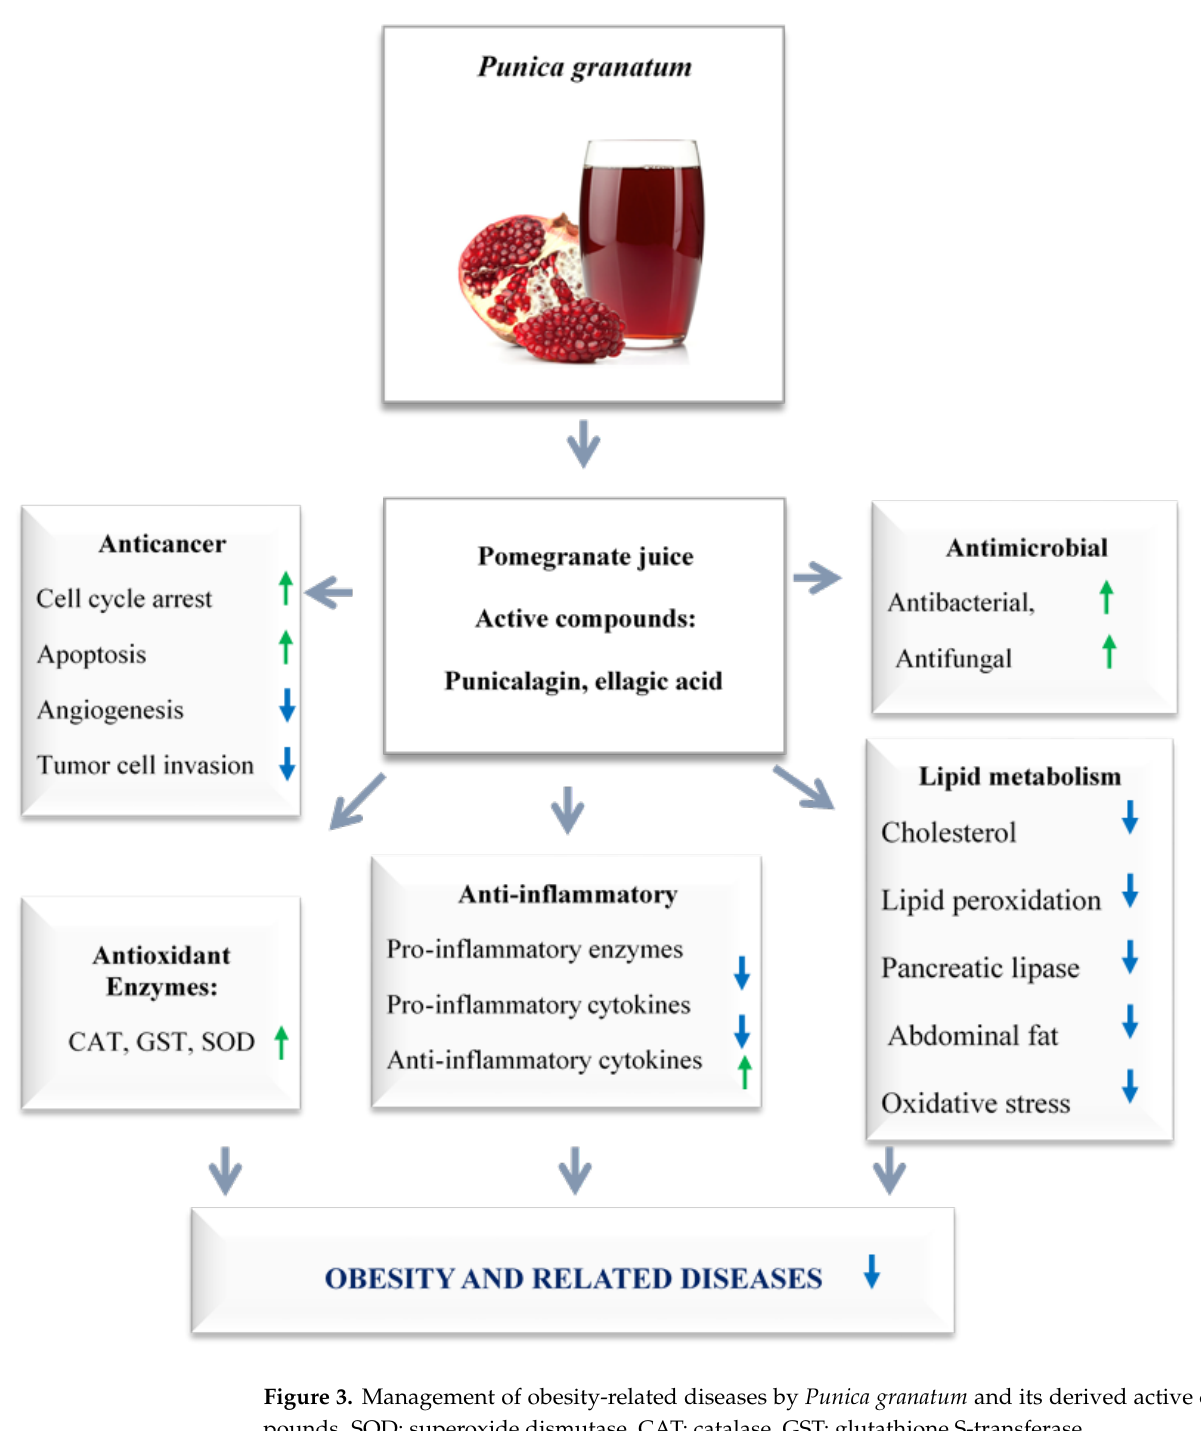
Figure 3. Management of obesity-related diseases by Punica granatum and its derived active com- pounds. SOD: superoxide dismutase, CAT: catalase, GST: glutathione